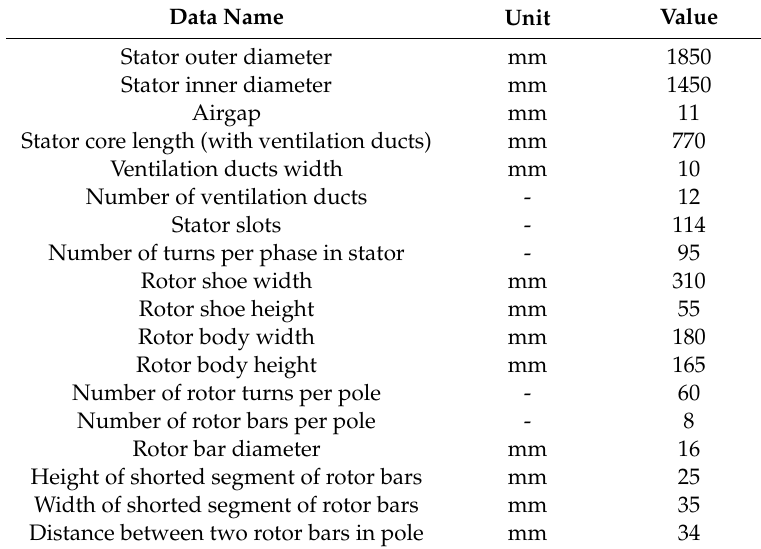
Figure 1. The field-circuit model of the investigated hydro generator with a visible finite element mesh. Table 2. Main geometry dimensions of the investigated